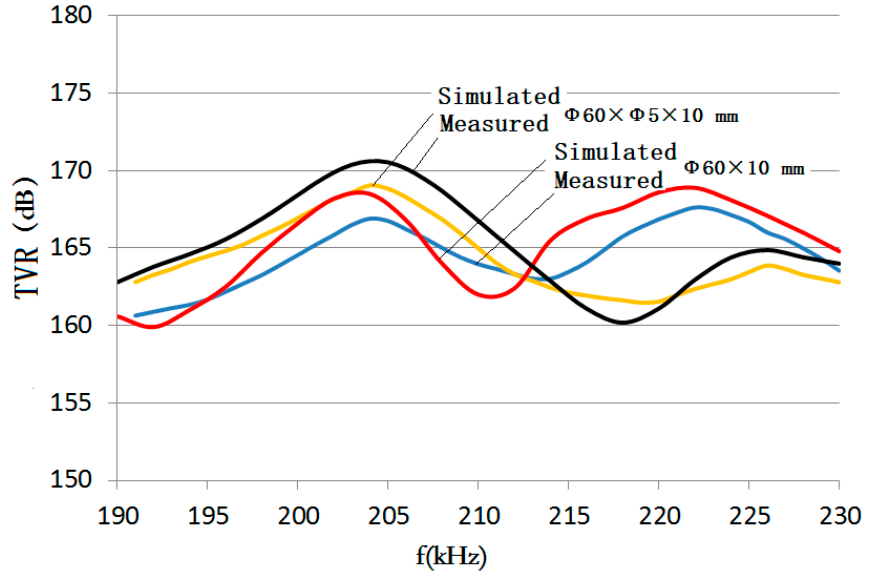
Figure 9. Transmission voltage response curve of two transducers.